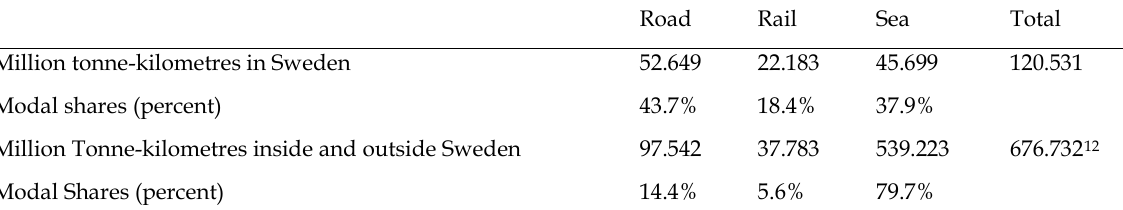
Table 2. Freight flows in, to and from Sweden: Transport performance (1000 tonne-kilometer) and modal shares in percent in the base scenario